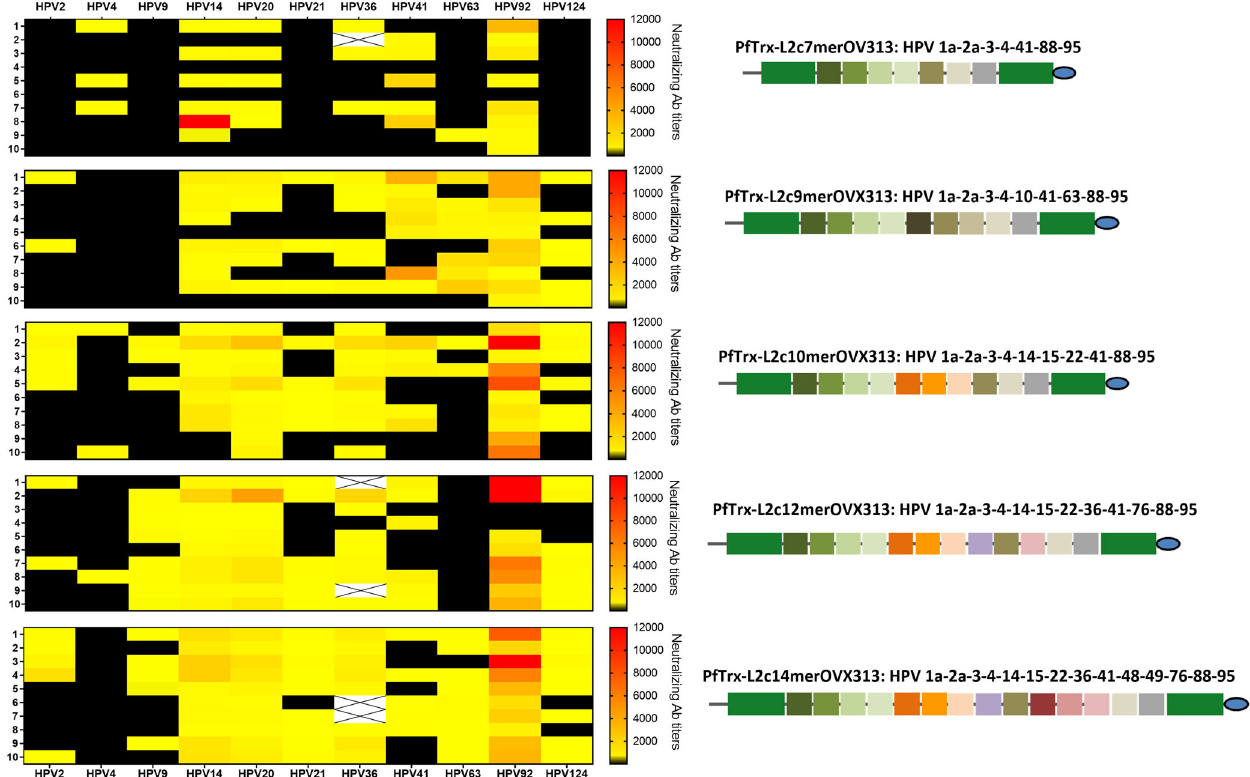
Fig. 5 Two high-complexity candidate vaccines (12mer and 14mer) induce broadly neutralizing antibody responses to cutaneous HPV types. Heat maps show neutralizing antibody titers to 11 cHPV types measured by the L1-PBNA in sera from 10 mice immunized with 20 µg of the indicated antigens (each row represents one serum). Antibody titers ranging from 50 to 12,000 are color-coded in yellow to red; the black color indicates EC50 values <50 (no neutralization). A cross mark indicates sera that were not tested for HPV36 due to a limiting sample